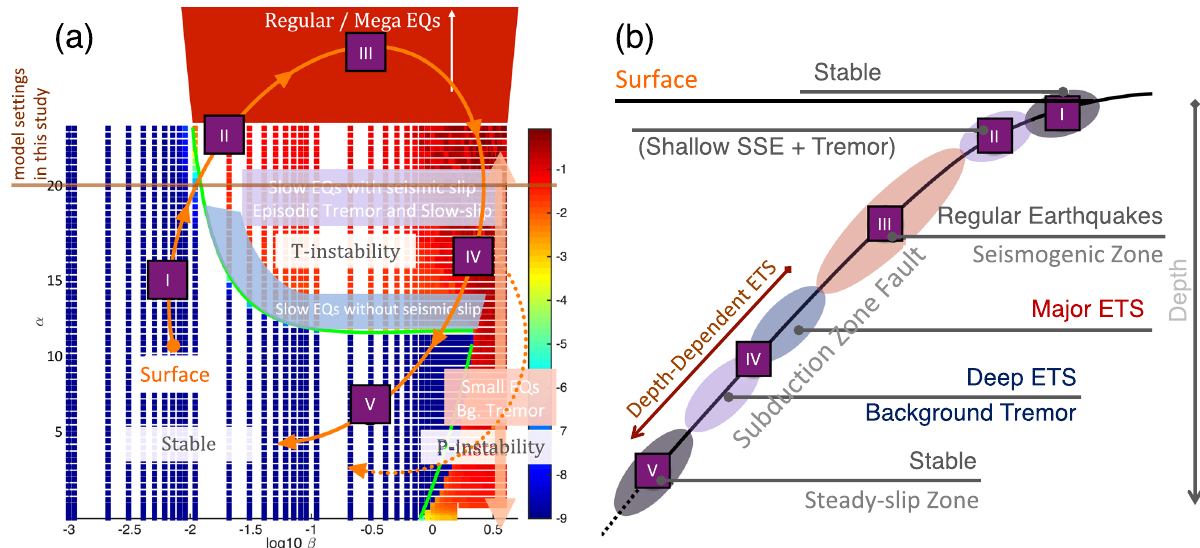
Fig. 9 A concept model of uni fi ed mechanism of slow-to-fast earthquakes for subduction zone fault. a Fault stability diagram. Color shows the logarithmic max slip rate (log10 of m (cid:2) s (cid:3) 1 ) of heterogeneous faults with various ratio of asperity/matrix effective normal stress α ¼ σ asp = σ bg (asperity effective normal stress/background matrix effective normal stress, y -axis) and asperity criticalness β ¼ L seismic, blue: steady-slip, turquoise-yellow: slow-slip. With variation of α and β fault can transit from stable (steady-slip) to slow and fast earthquakes (path I – V). b Schematic view of generalized subduction zone fault with depth-dependent episodic tremor and